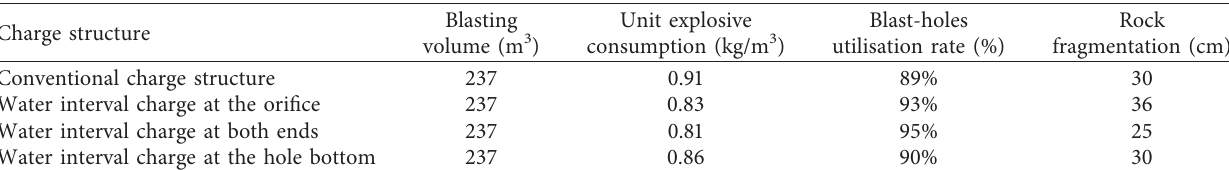
Table 6: Blasting effect of the four charging structures.